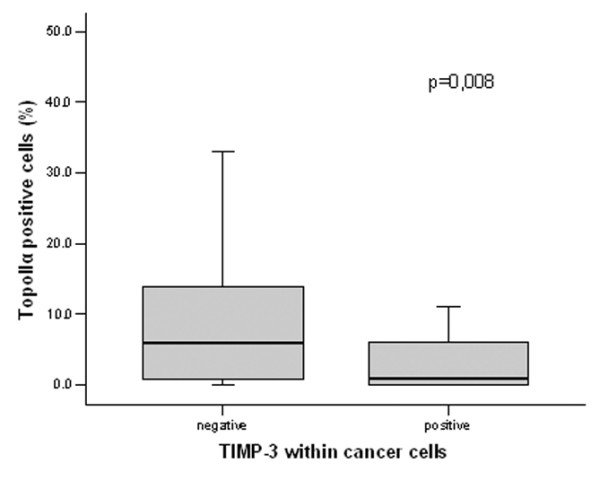
Relation between the expression of TIMP-3 and topoIIα proteins. Graphic representation of the relationship between tissue inhibitor of metalloproteinases (TIMP)-3 in cancer cells and topoIIα protein expressions.